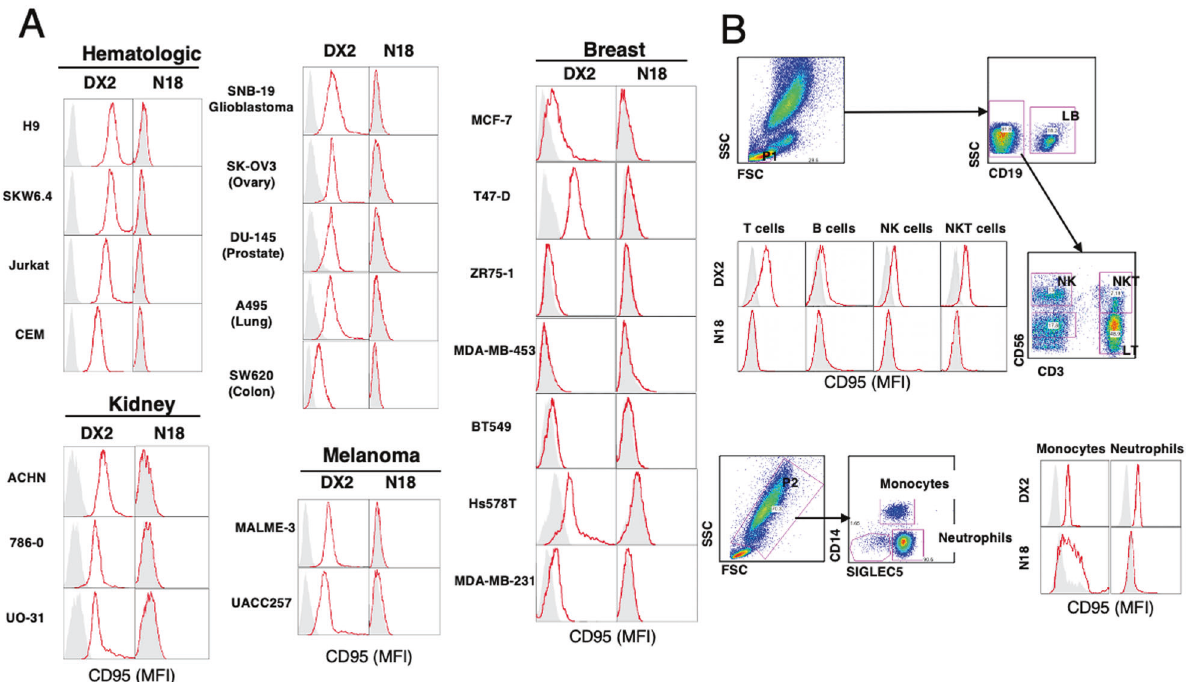
Fig. 2 The amino-terminal region of CD95 is lost in all cancer cells and normal blood cells but macrophages. A Indicated cancer cell lines were stained with DX2 and N18 as primary antibodies (red lines) or with isotype-matched control IgG (shadowed histogram) and CD95 expression was evaluated by fl ow cytometry. B Normal human peripheral blood cells (PBLs) were stained by DX2 or N18 (red lines) or isotype- matched control IgG (shadowed histogram) and CD95 expression was analyzed by fl ow cytometry. Cell populations were evaluated by using speci fi c markers (T cells (CD3 + ), B cells (CD19 + ); NK cells (CD56 + ), NKT cells (CD3 + CD56 + ), monocytes (CD14 + SIGLEC5 + ) and neutrophils (CD14 − SIGLEC5 + )). Note that the N-terminal domain of CD95 was only detected in the monocyte